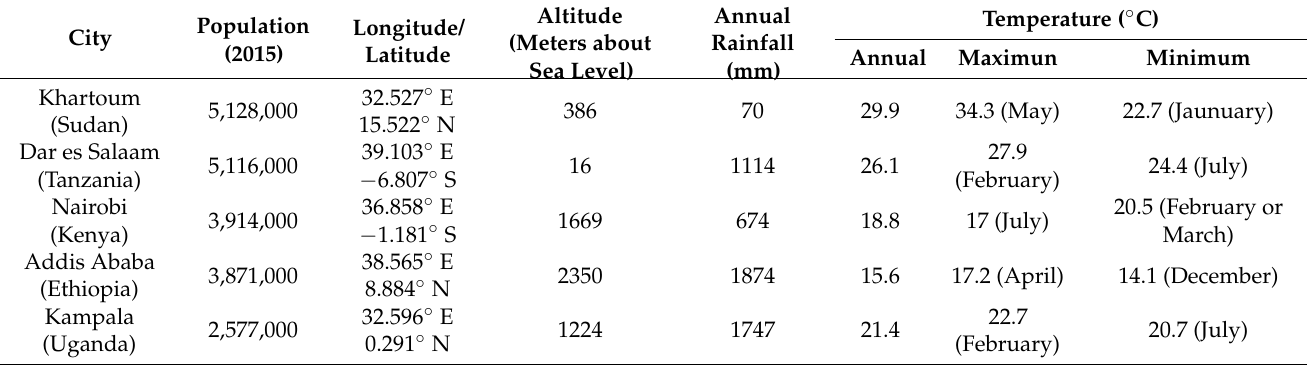
Table 1. Geographic and climatic information of the study